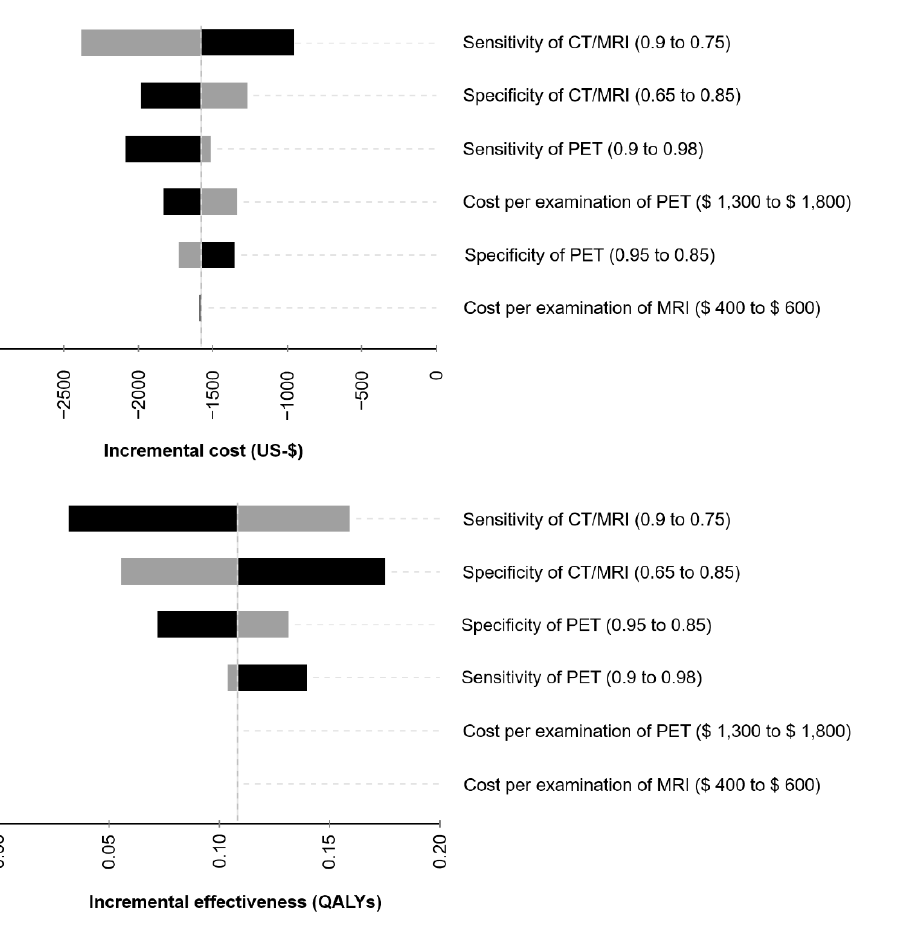
Figure 2. Deterministic sensitivity analysis: ( a ) The influence of various input variables on the incremental cost (US-$) is displayed in a tornado diagram. ( b ) Impact of input variables on the incremental effectiveness expressed by quality-adjusted life years (QALYs) is displayed accordingly. The input variables were varied within reasonable ranges (indicated in the brackets) and the resulting incremental costs and effectiveness of 18F-FDG-PET/CT vs. CT/MRI-strategies were com- puted.